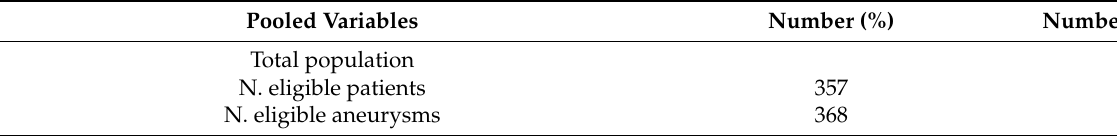
Table 1. Pooled study baseline characteristics and